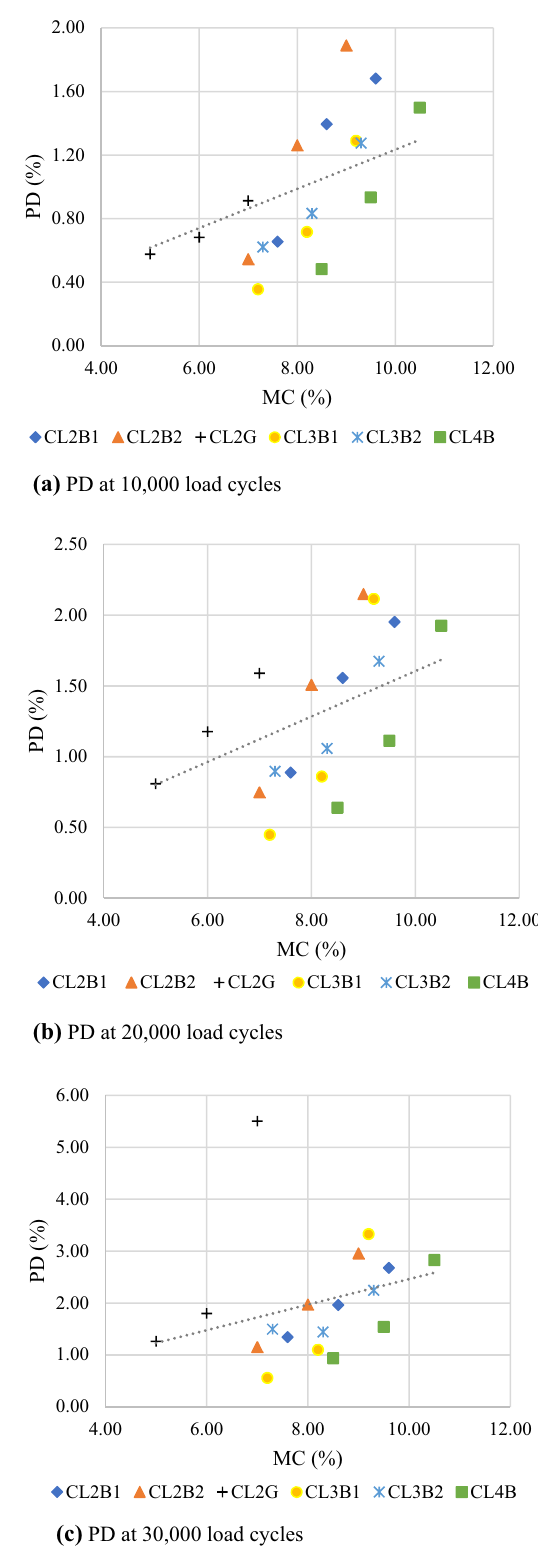
Fig. 6 Effect of moisture content on PD of